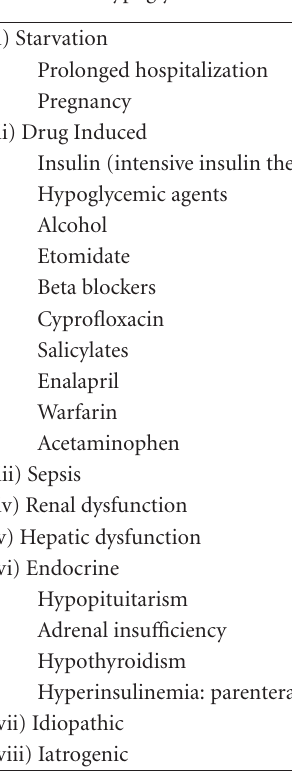
Table 1: Hypoglycemia causes in neurocritical care